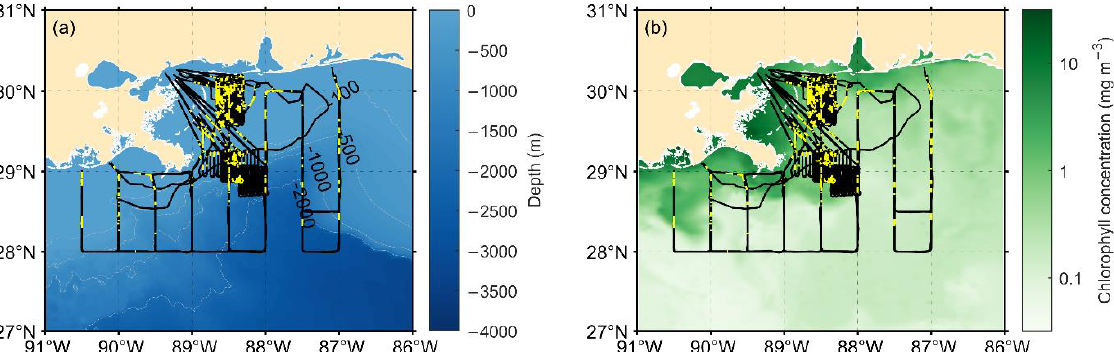
Figure 5. Maps of thin phytoplankton layer distribution. The solid black lines are the detection route, and the yellow lines are the positions where thin layers were detected. ( a ) Thin layer distribution plotted on the base map of seawater depth; ( b ) Thin layer distribution plotted on the base map of chlorophyll concentration.